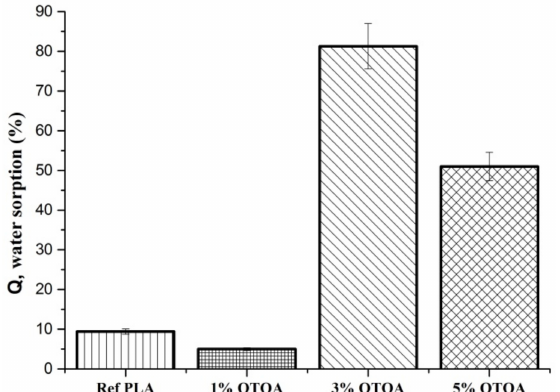
Figure 6. Sorption capacity (Q) of nonwoven PLA mats: pristine PLA, PLA + 1% OTOA, PLA + 3% OTOA, PLA + 5% OTOA samples.